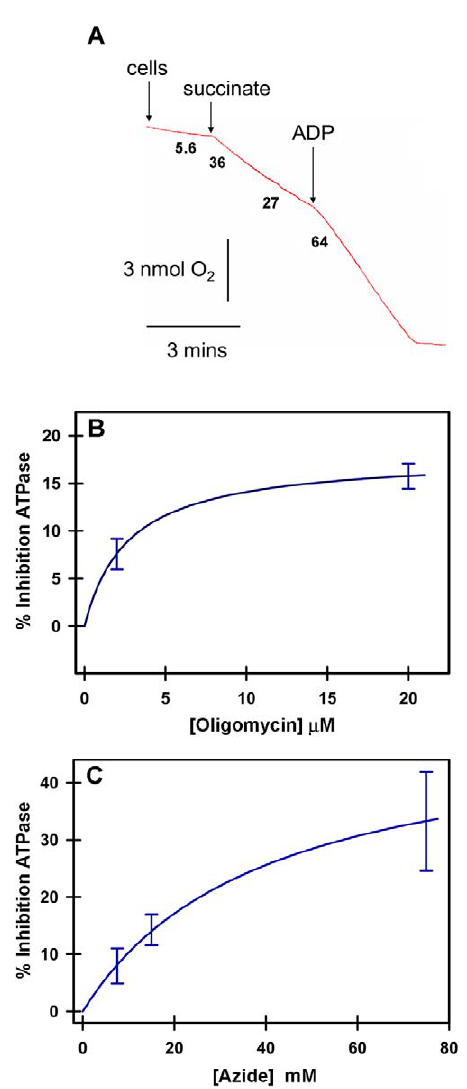
Figure 1. ADP-stimulated oxygen consumption and inhibitor insensitivity of ATPase activity in T.thermophila mitochondria. (A) Succinate-dependent oxygen consumption in digitonin-permeabilized T. thermophila cells is stimulated upon addition of ADP, consistent with oxidative phosphorylation by a mitochondrial electron transport chain and ATP synthase. Additions to the oxygen electrode reaction chamber are indicatedbyarrows.Final concentrations were 0.3 m g/ m l cell protein,5 mM succinate, 17 m M ADP. Numbers below the trace give the rate of oxygen consumption in nmoles O 2 /min/mg protein). (B) and (C) show the concentration dependence of the inhibition of the ATPase activity of isolated T. thermophila mitochondria by oligomycin and sodium azide, respectively. Error bars indicate standard deviation ( n =3). Yeast mito- chondrial ATPase activity was inhibited 50% by 1 m M oligomycin and 91% by 1 mM sodium azide (not shown) under these assay